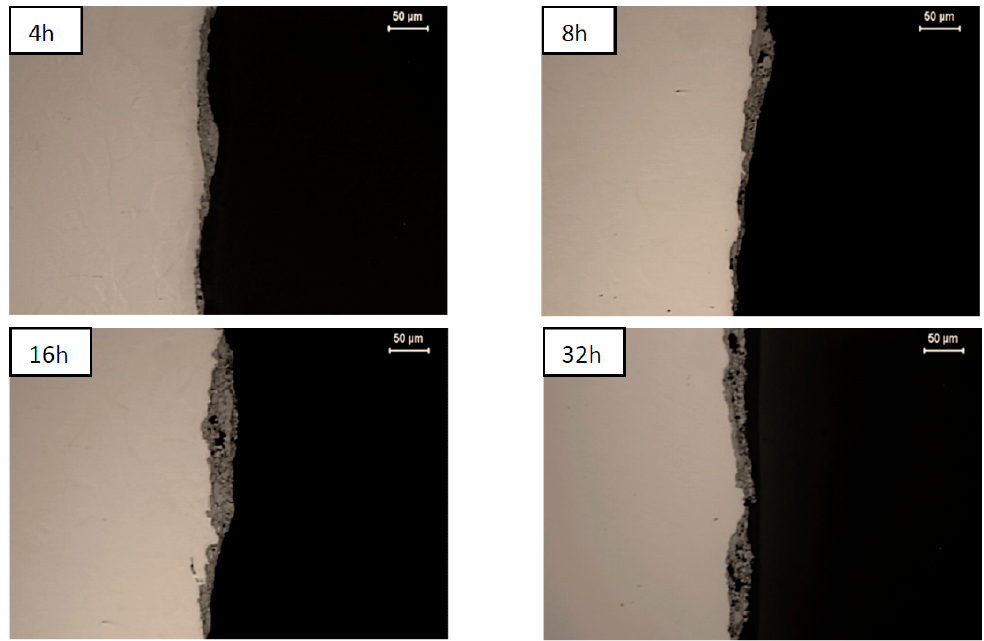
Figure 3. Images of composite coatings on nickel substrates milled for 4, 8, 16, and 32 h.